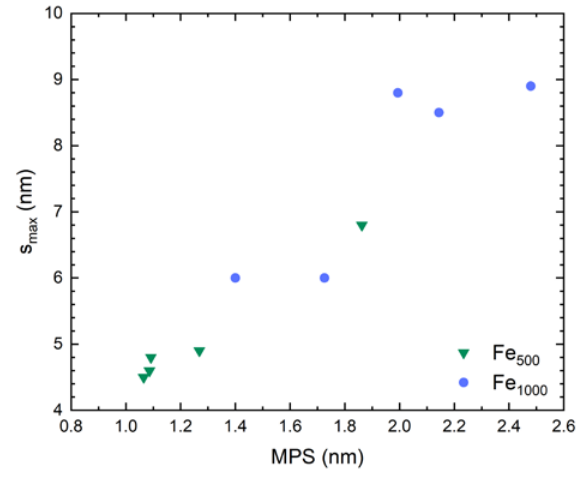
Figure 14. Estimated bottleneck tunneling barrier widths in case conduction along each path is dominated by one single gap.